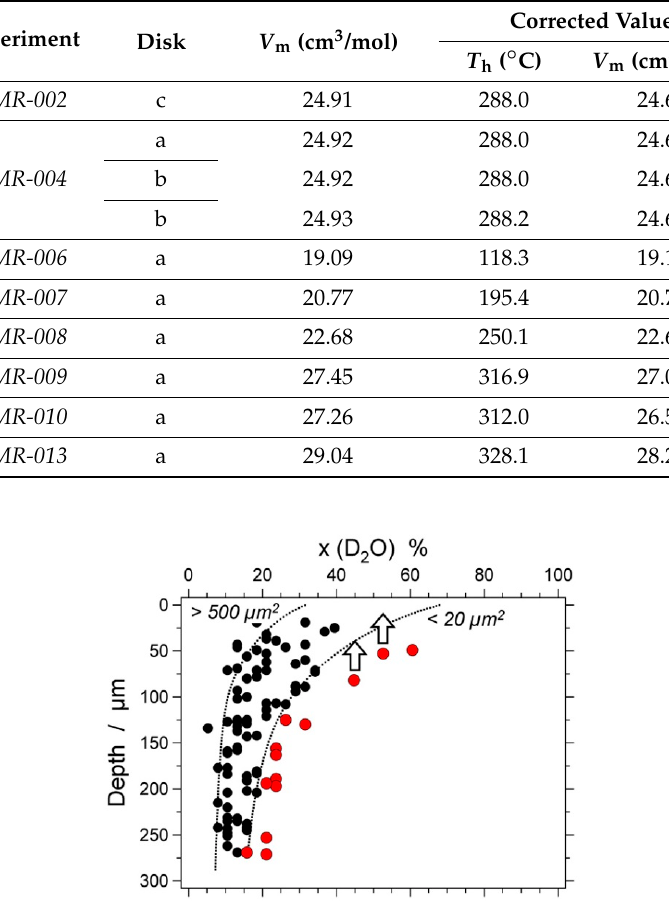
Figure 10. D 2 O concentration profile of synthetic fluid inclusions in quartz after the re-equilibration experiment GMR-004a . The dashed curves illustrate the concentration profiles for specific constant sizes of fluid inclusions (area of <20 µm 2 and >500 µm 2 in the microscope view). The red symbols represent shifted values (open arrows) due to an overestimated distance between the inclusion and quartz-surface (see also Figure 12b).